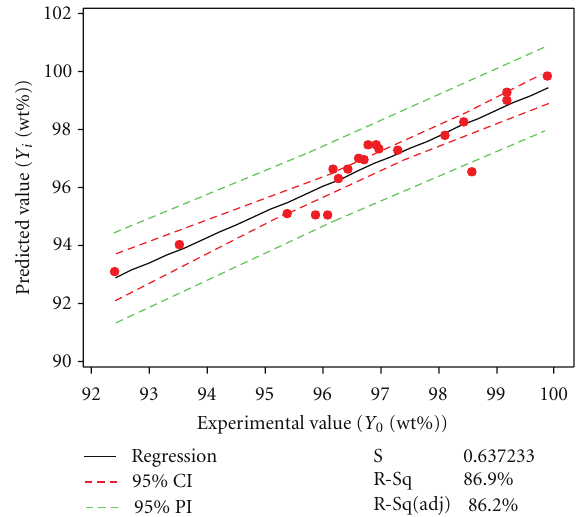
Figure 2: The fitted line plot indicating the correlation between the predicted and experimental ( Y 0 ) values of methyl esters (biodiesel) content. Fitted line plot for transesterification yield. Predicted value ( Y i , %wt) = 11.99 + 0.8754. Experimental value ( Y 0 ,